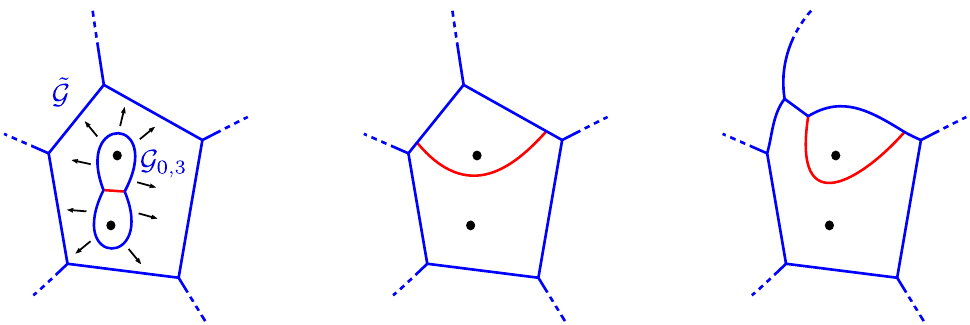
Figure 21. The contraction of G 0 ; 3 with ~ G is determined by the cyclic position of the vertices of G 0 ; 3 along the polygonal boundary of ~ G . A sequence of Whitehead moves always produces a bigon.